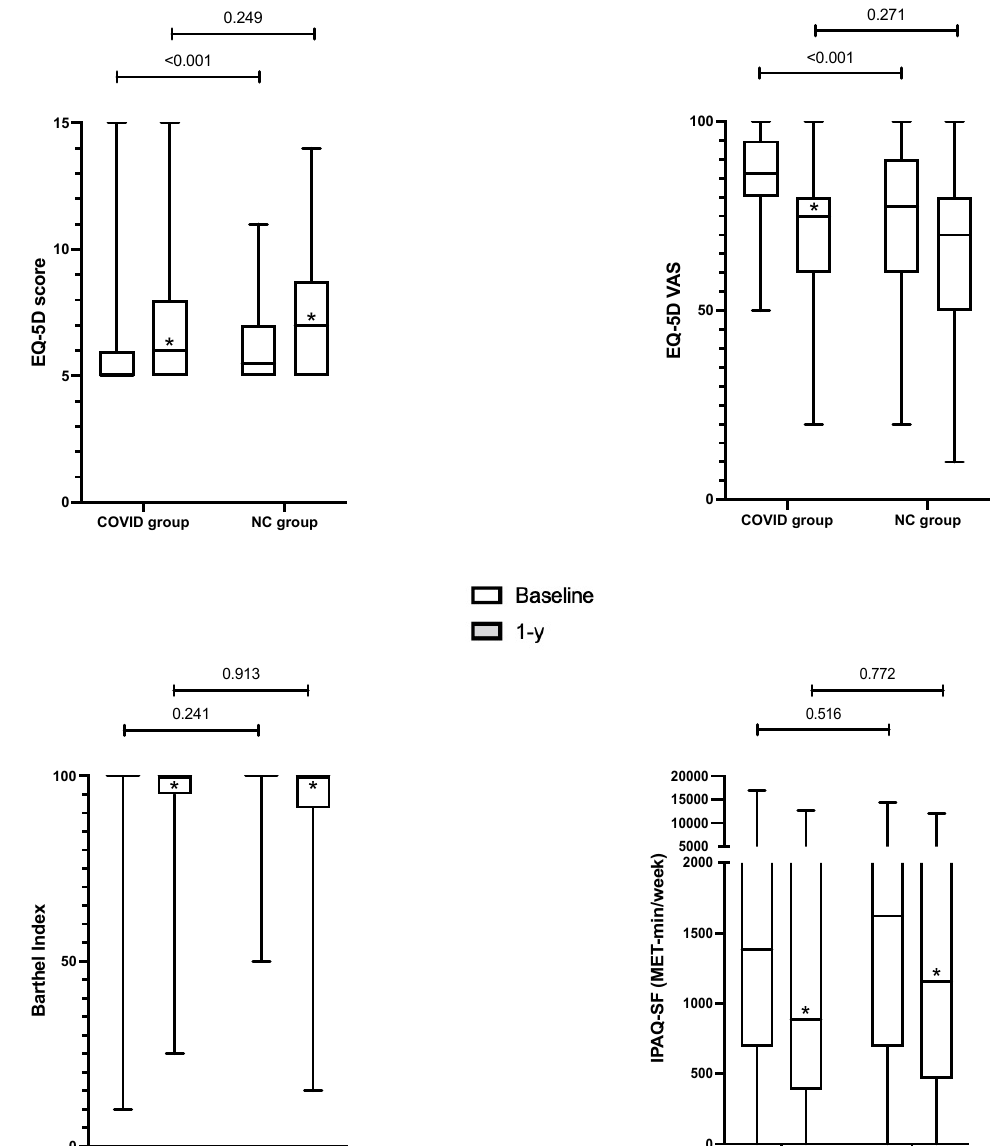
Figure 2. One-year functional assessment (grey boxes) compared to pre-ICU status (baseline, white boxes), in the COVID and NC groups. (*: significant difference between baseline status and one-year status within a group).